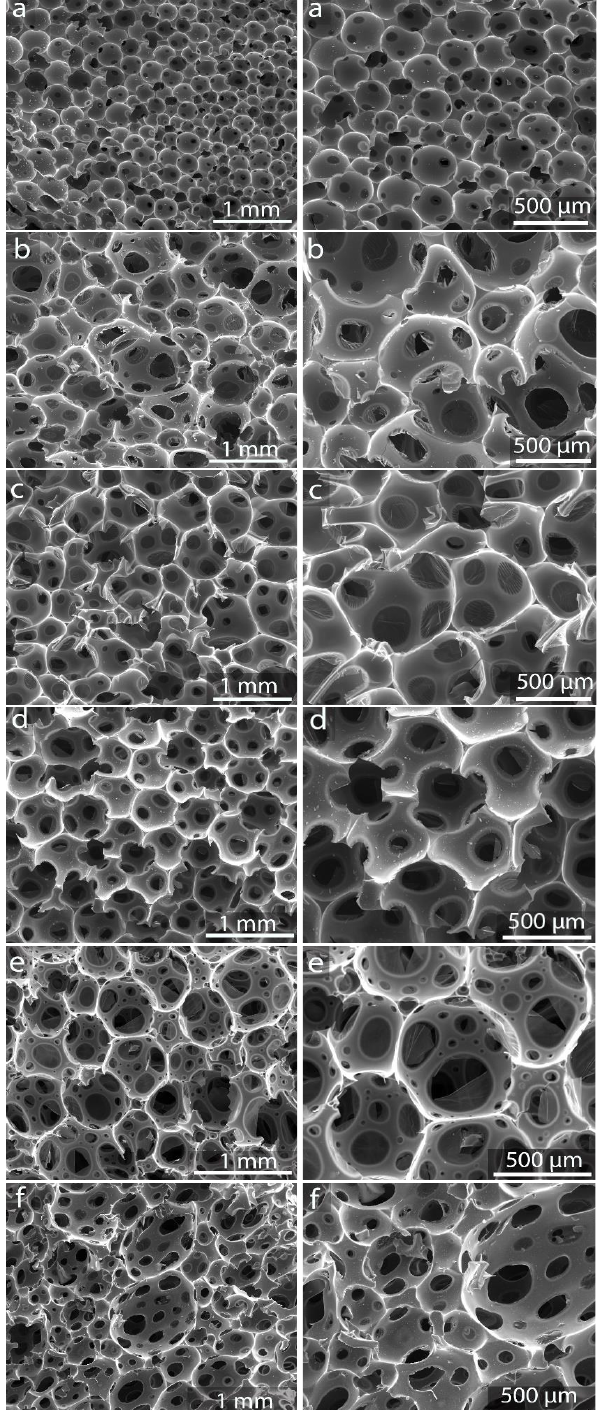
Figure 5. SEM micrographies of rSF1 ( a ), rSF2 ( b ), SF ( c ) SF(C) ( d ), SF(Fe) ( e ), and SF(Ag) ( f ).